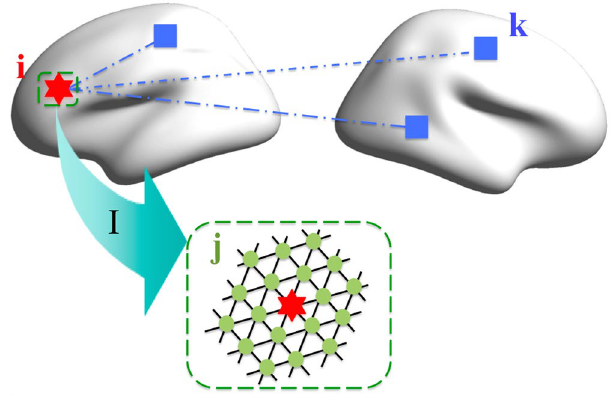
Figure 5. Schematic of the vIFC algorithm across cerebral cortex. There are three types of vertices, i.e., {i}, {j ∈ I}, and {k ∉ I}. Given vertex i , I stand for its second 2 neighborhood cluster, j represent the vertices within I, and k represent other vertices (outside the